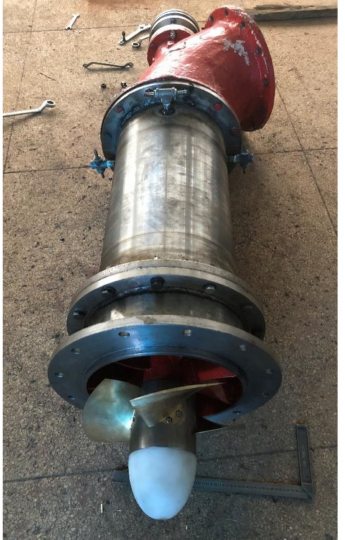
Figure 20. Model pump